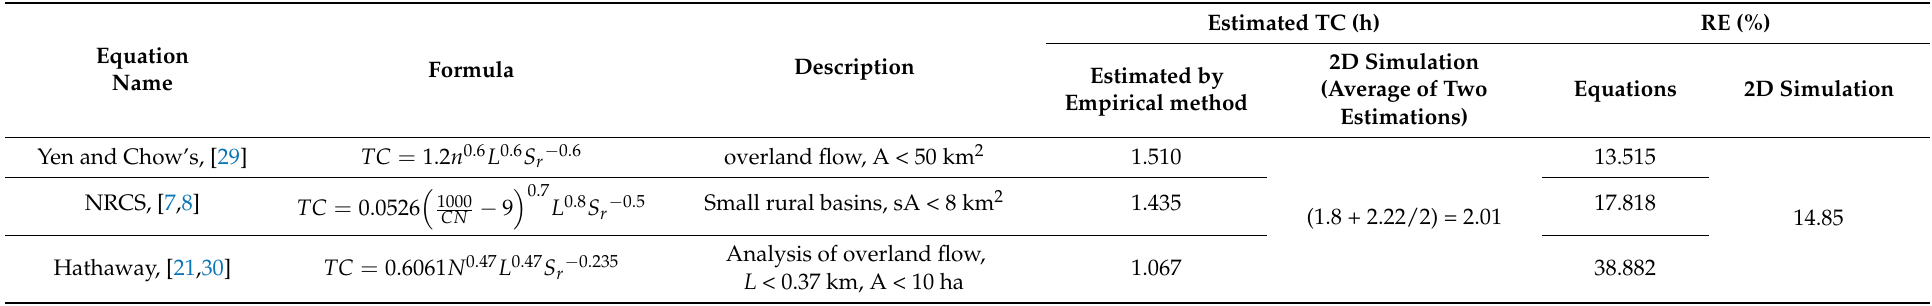
Table 6. TC (h) and RE (%) for methods based on n (category